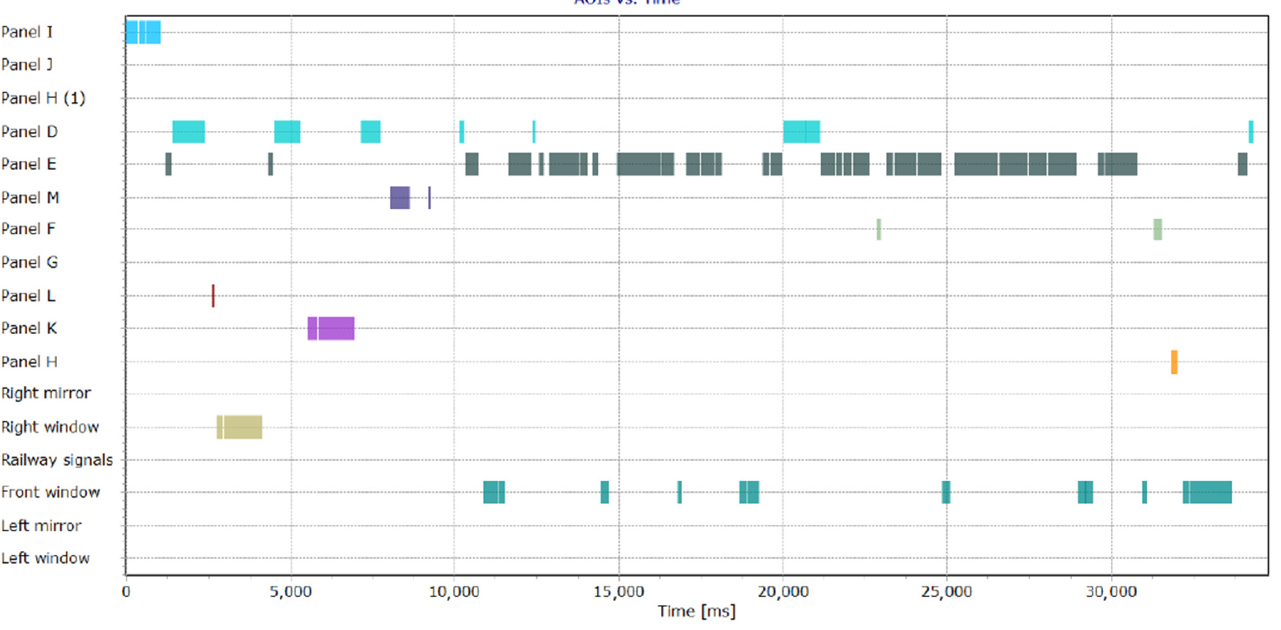
Figure 7. AOI sequence chart of average departure procedure from railway stop Predmier.